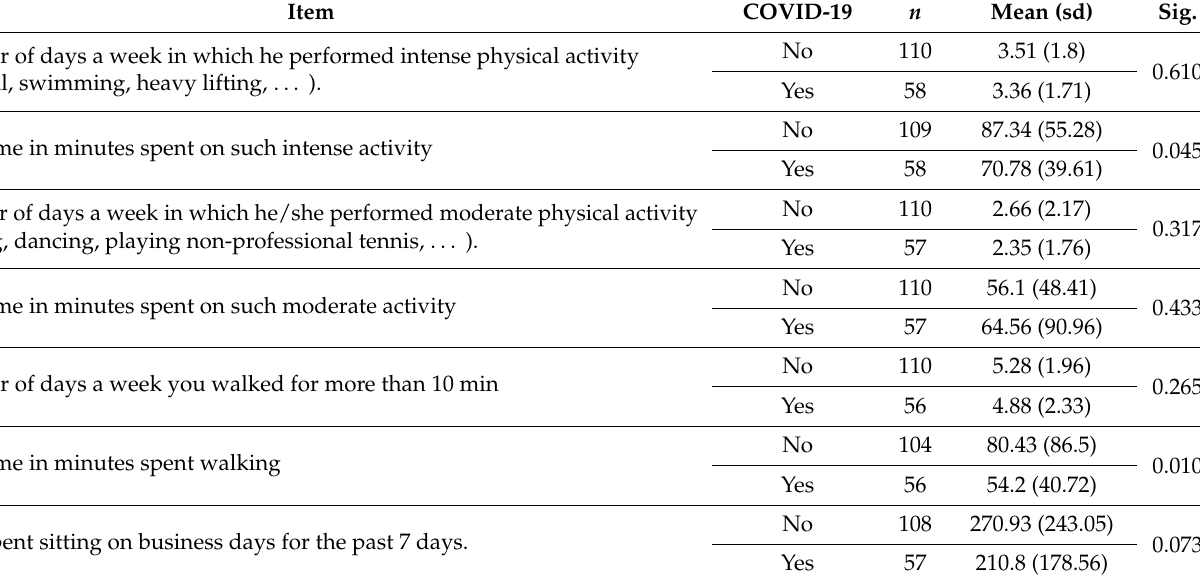
Table 3. IPAQ questionnaire according to COVID-19